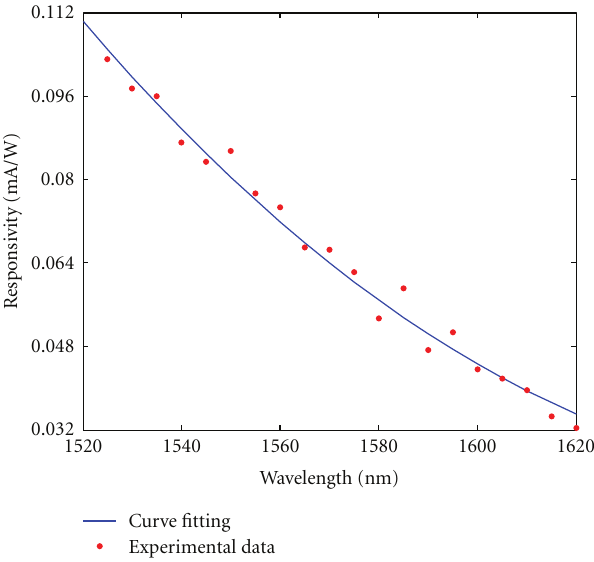
Figure 8: Photogenerated current versus wavelength at − 1V of reverse bias